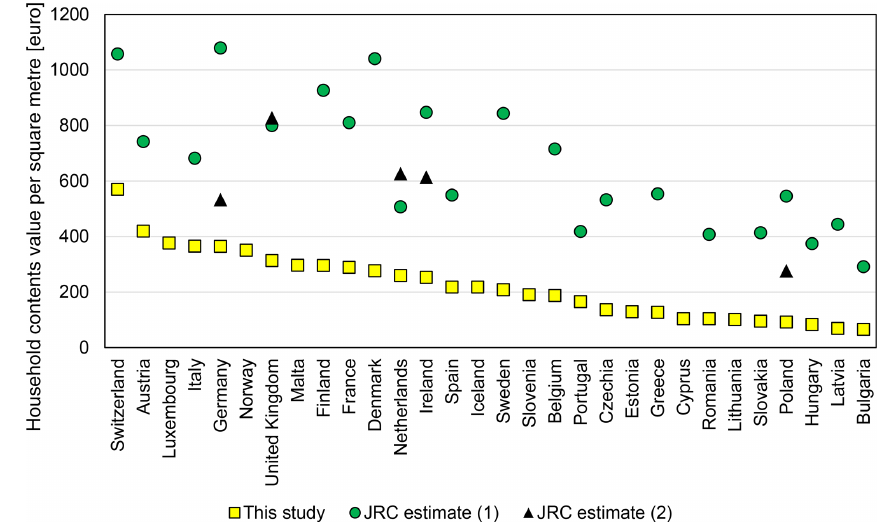
Figure 9. Comparison of household content values per square metre of floor space estimated for the year 2010 in this study with two estimates by the Joint Research Centre (Huizinga et al., 2017).